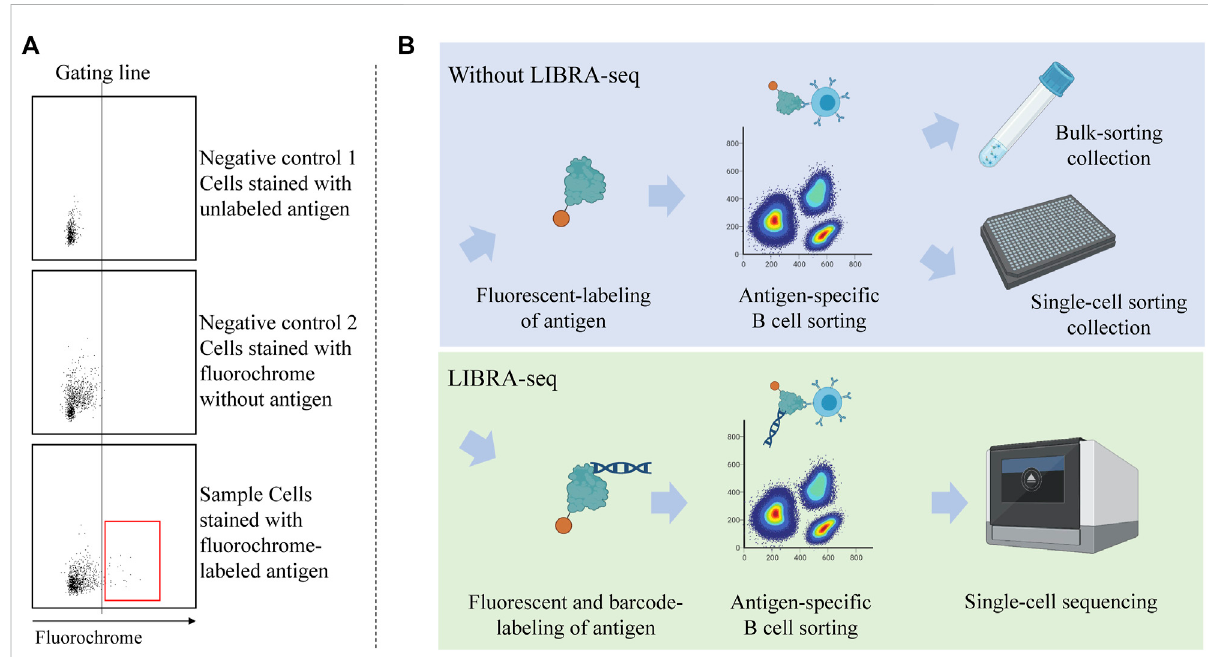
FIGURE 2 Antigen-speci fi c B cell sorting with or without LIBRA-seq. (A) Utilization of double negative control population to determine gating line for selecting antigen-binding cells. The population inside the red box is considered “ antigen-binding. ” (B) Work fl ow of antigen-speci fi c cell sorting with and without the utilization of LIBRA-seq. Samples can be obtained from vaccinated donors or patients with a certain disease. LIBRA-seq uses barcoded antigen along with the fl uorescent label, that can be read by the NGS